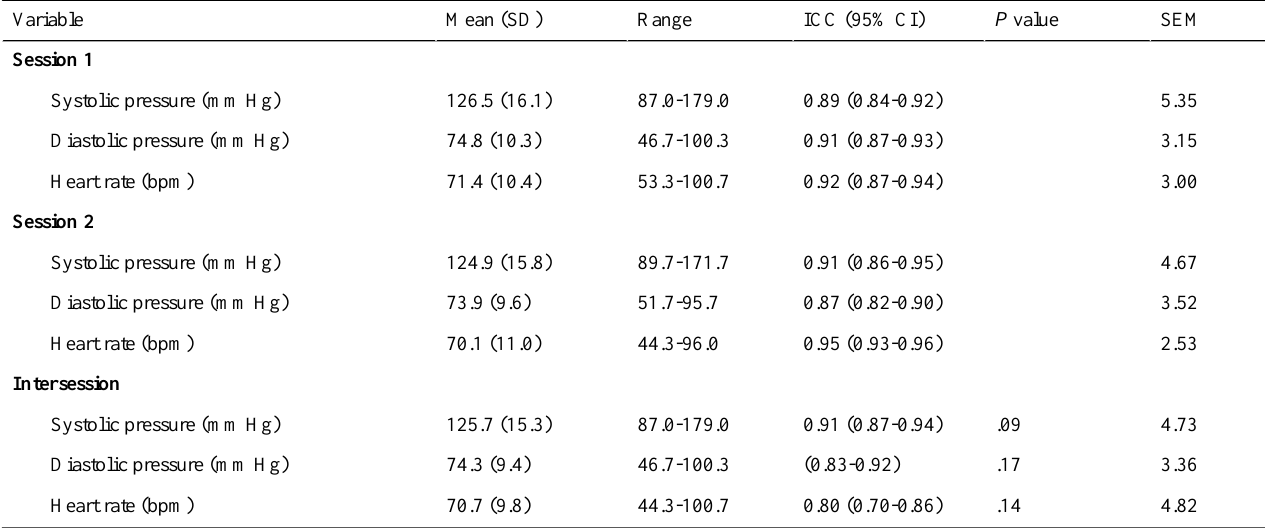
Table 2. Intrasession and intersession reliability for the QardioArm in sessions 1 and